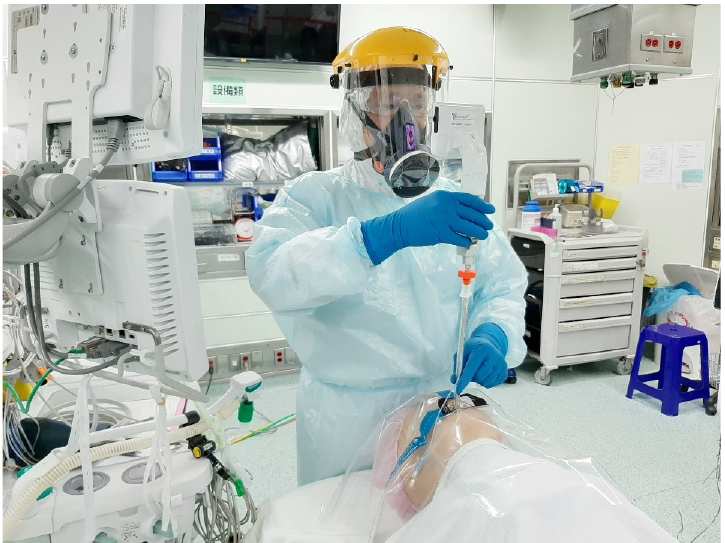
Figure 3. The simulation of applying the video-assisted intubating stylet technique in a mannequin covered with a clear plastic sheet over the head area and upper torso. The tracheal intubator was fully equipped with the PPE and kept a reasonably long distance away from the at-risk area of the mannequin. The technical note for preparation and specifications of the clear plastic sheet barrier can be found in the reference [11].